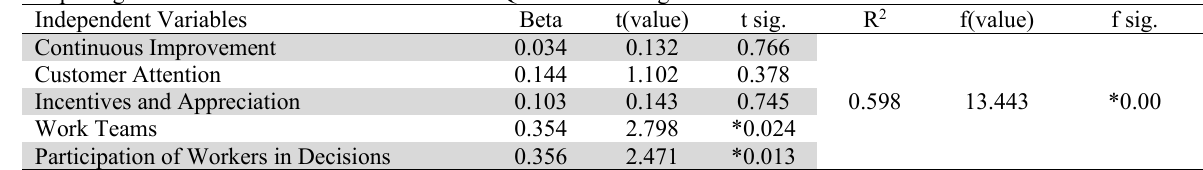
Simple regression test results to test the effect of TQM on marketing educational services. Independent Variables